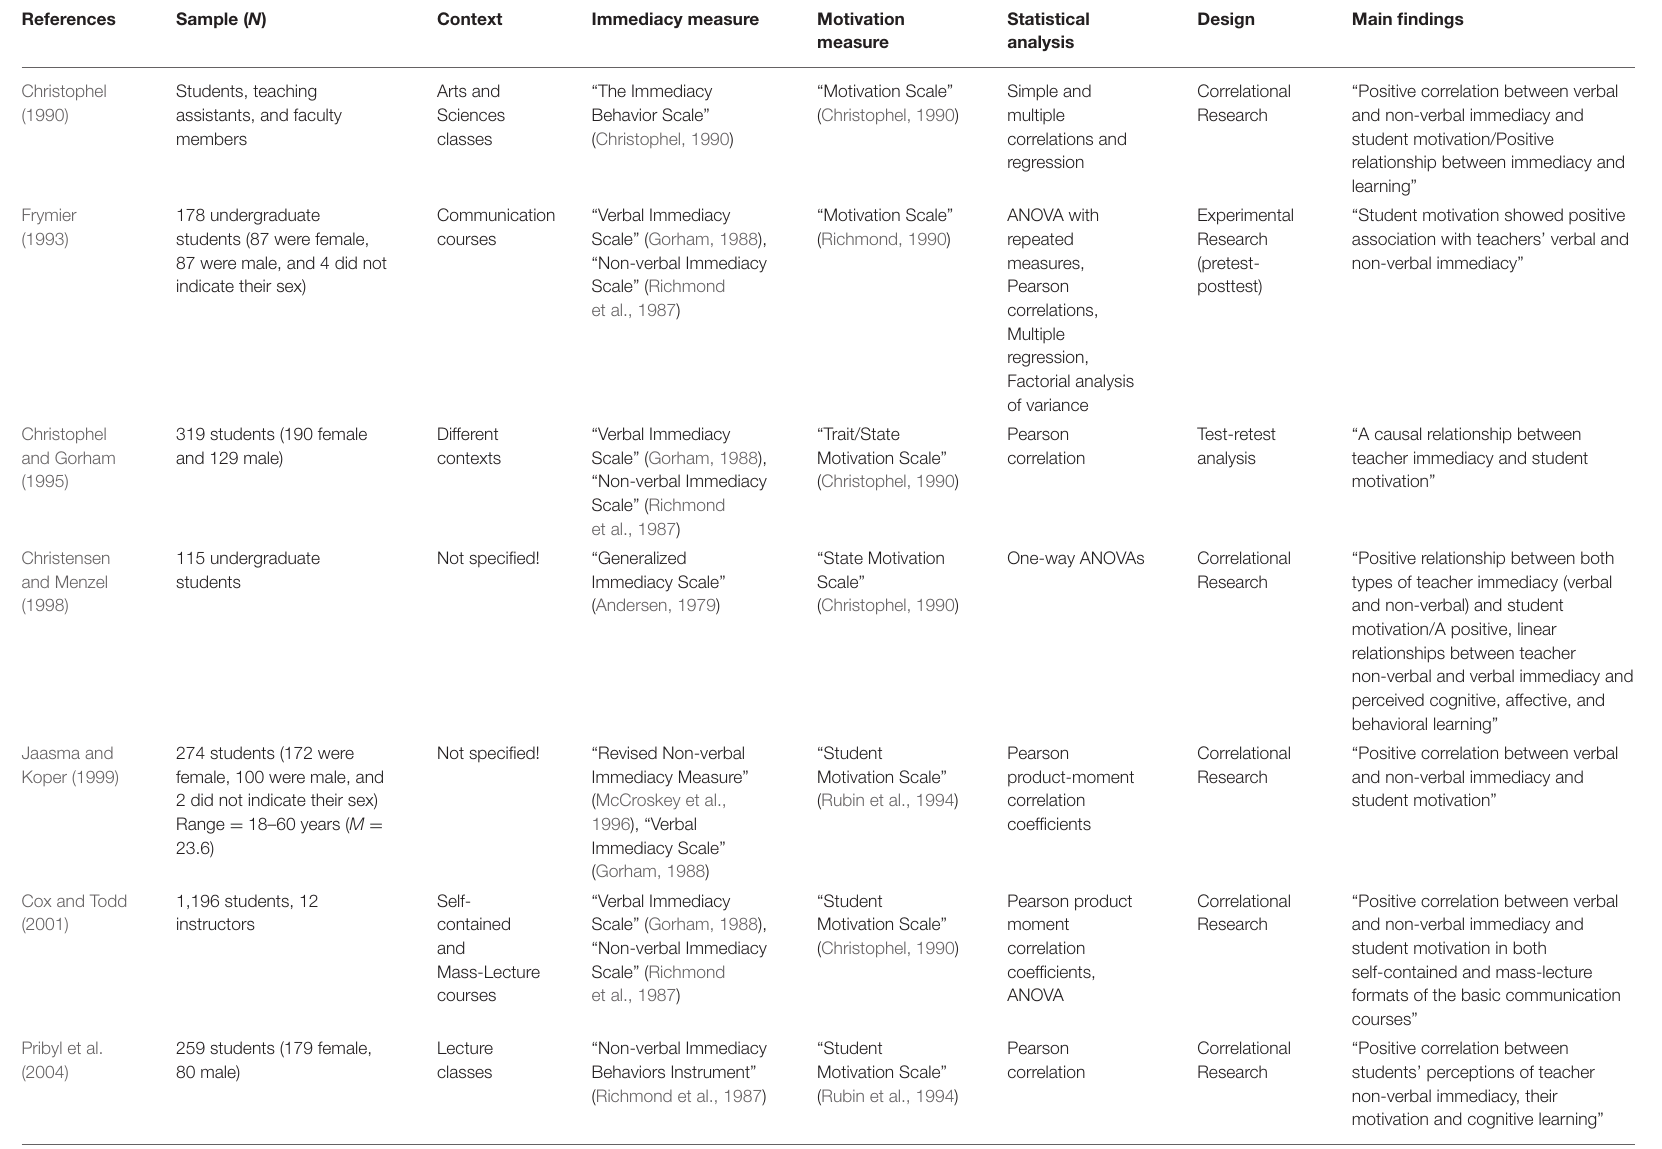
TABLE 1 | Studies examining teacher immediacy and student